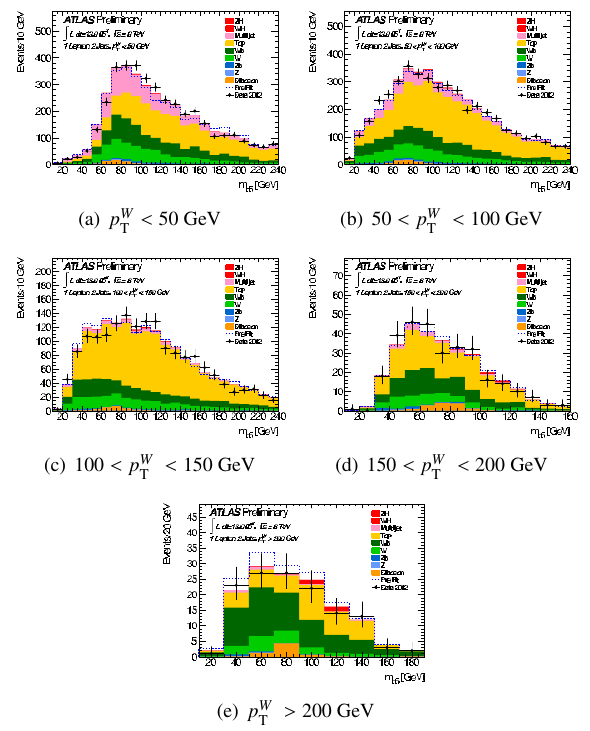
Figure 3. The m distribution in data for the five categories b ¯ b of the one lepton analysis [9]. The signal shown is for m H = 125 GeV. The background from the V + jet process is separated into the V + b and the sum of the V + c and V + light components. The background expectation is shown after the profile likelihood fit (solid) and compared to the predictions from the pre-fit Monte Carlo simulation (dashed). The size of the combined statistical and systematic uncertainty is indicated by the hashed